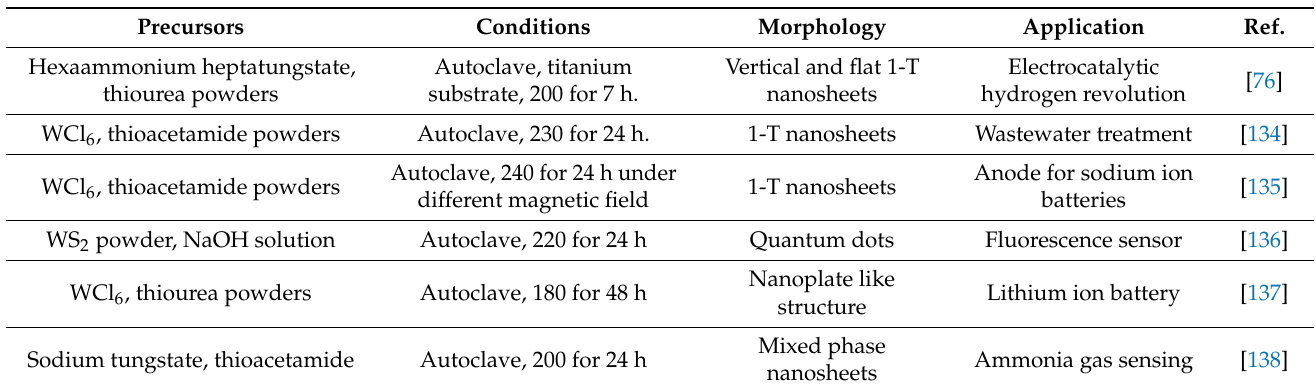
Table 4. Examples of hydrothermal synthesis of WS 2